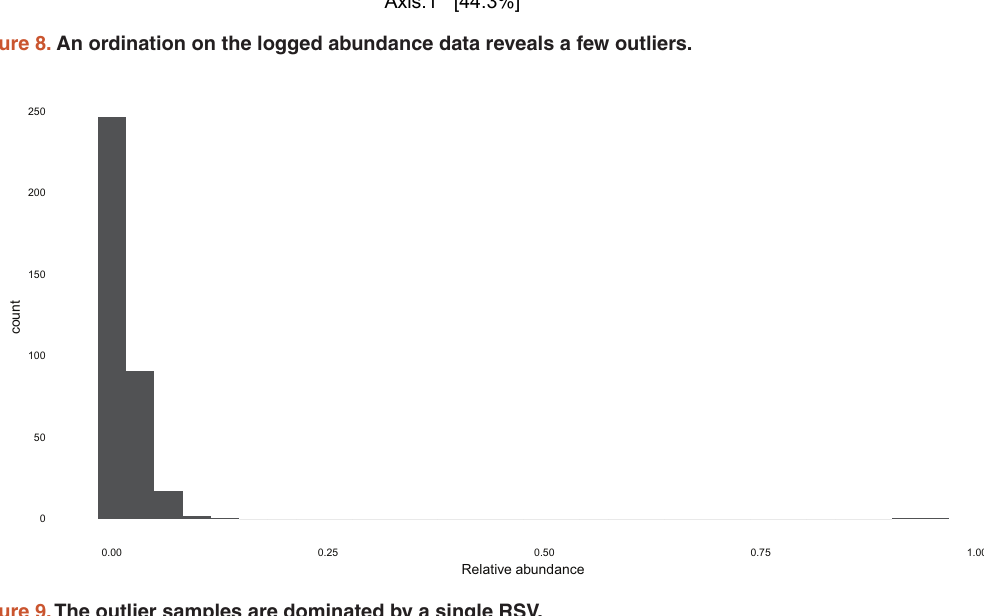
Figure 9. The outlier samples are dominated by a single RSV.